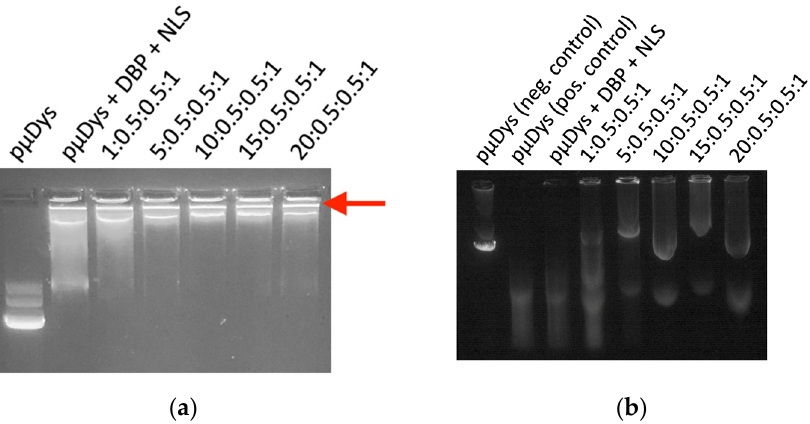
Figure 2. Gel images demonstrating the ability of G5-SMTP–DBP–NLS–pµDys to form polyplexes and encapsulate and protect pµDys. ( a ) Polyplexes of charge ratios 5:0.5:0.5:1 and higher are capable of fully binding pµDys, as indicated by the narrow band at the top of the gel (see arrow). ( b ) Polyplexes are capable of protecting pµDys from serum degradation, as shown by comparing the polyplex bands to the positive (lane 2) and negative (lane 1) control bands.